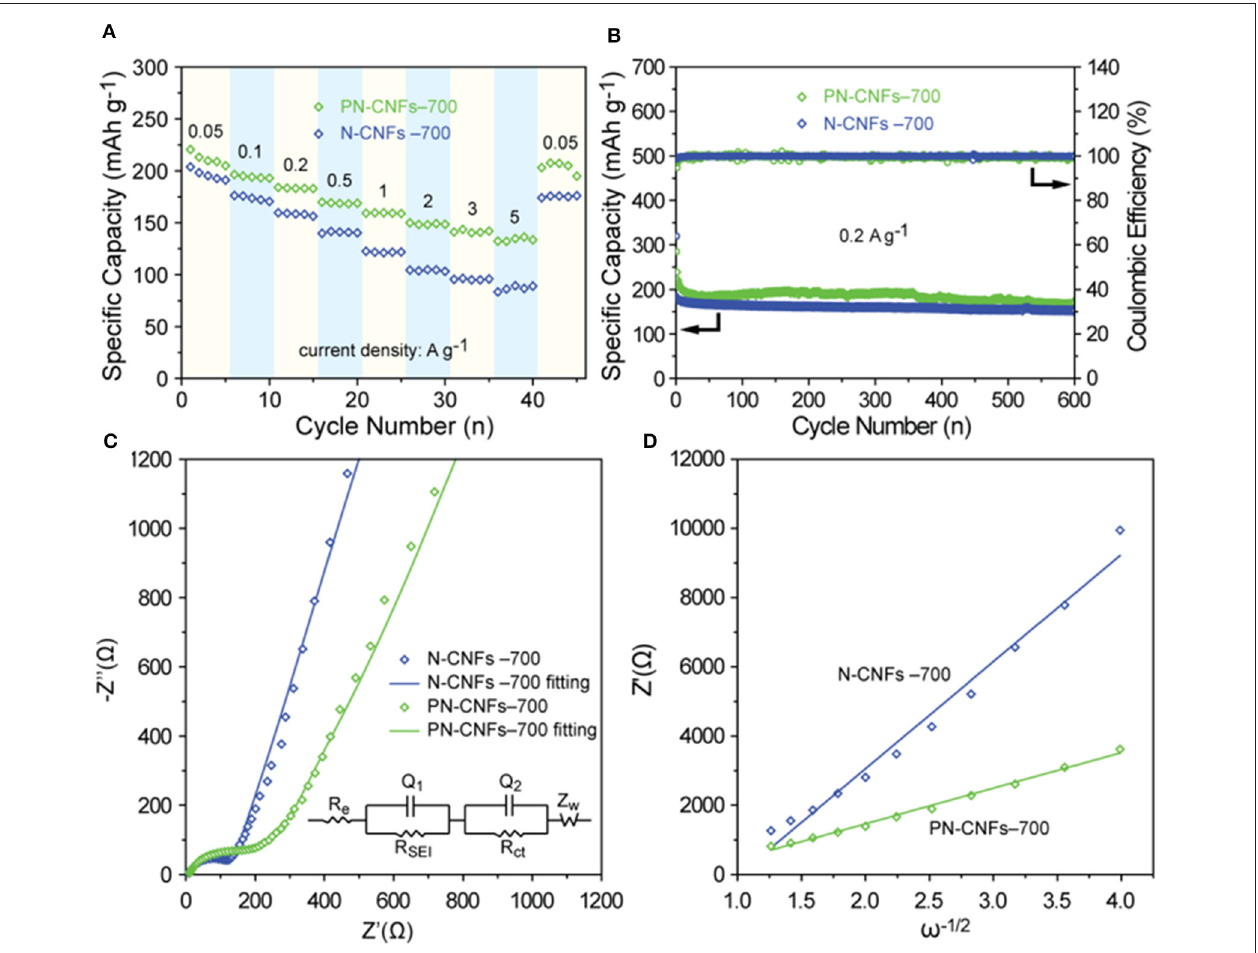
FIGURE 4 | (A) The rate performance of N-CFs-700 and PN-CFs-700; (B) cycle performance and Coulombic efficiency of N-CFs-700 and PN-CFs-700 for 600 cycles at a current density of 0.2A g − 1 ; (C) Nyquist plots of N-CFs-700 and PN-CFs-700 (the inset is the corresponding equivalent circuit diagram); (D) Z ′ - ω − 1 / 2 linear fitting curves in the low frequency